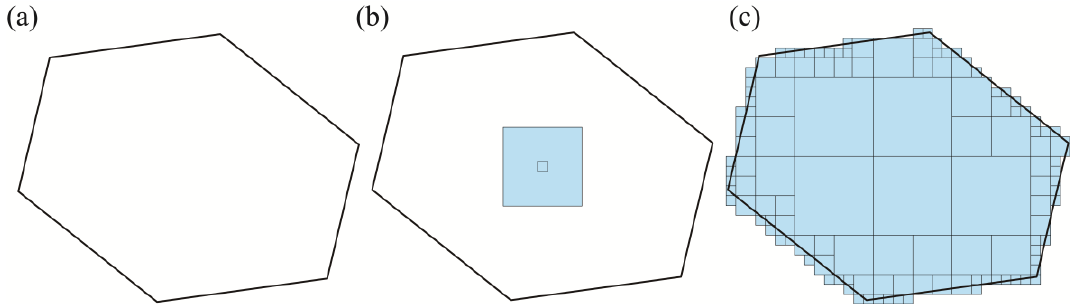
Figure 6. Spatial correlation index model: (a) Hexagonal grid code ID1; (b) GeoSOT location code ID2; and (c) Multi-scale grid set.